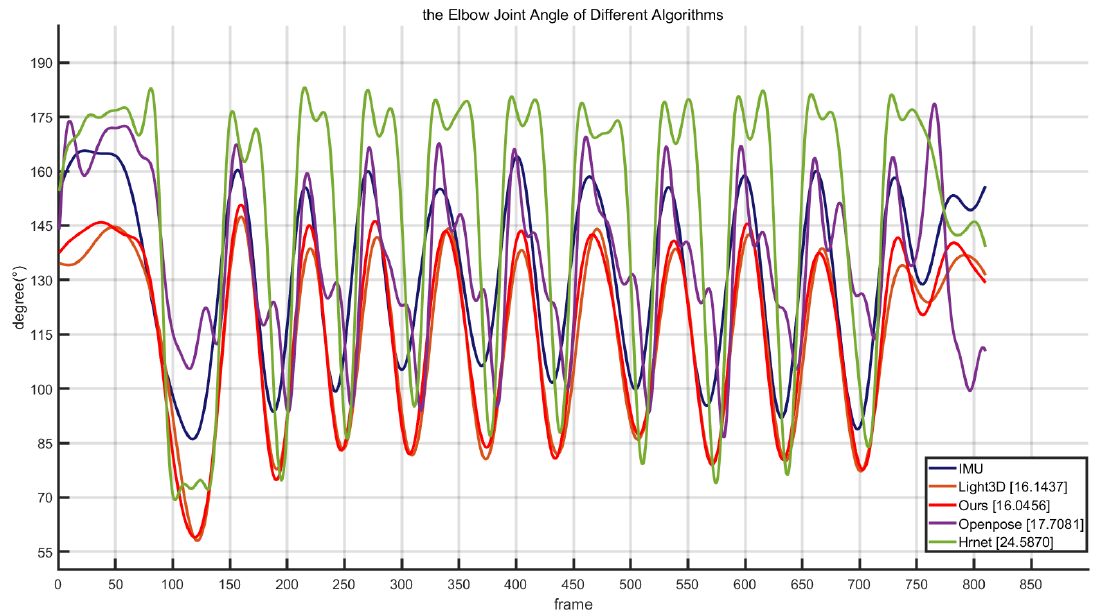
Figure 8. Elbow angle results estimated by different algorithms using the same video sequence.